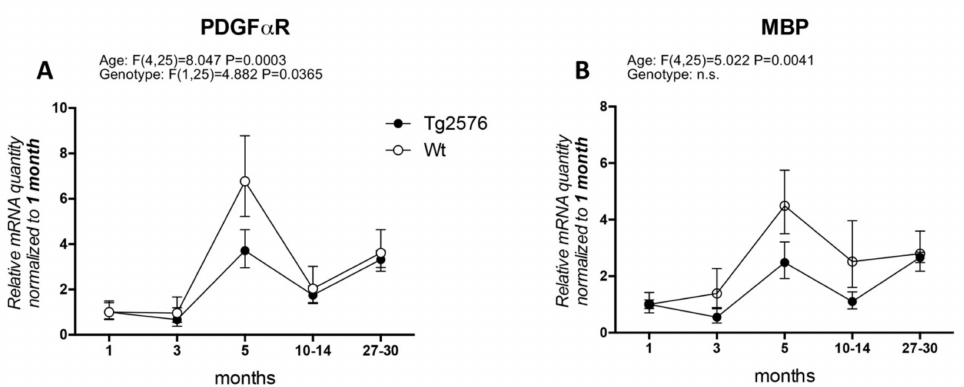
Figure 1. Age-related variation of oligodendrocyte lineage markers. ( A ) platelet-derived growth factor alpha receptor ( PDGF α R ) gene expression in Wt and Tg2576 at di ff erent age timepoints; ( B ) myelin basic protein ( MBP ) gene expression in Wt and Tg2576 at di ff erent age time points. Relative expression has been normalized to 1 month matched for each genotype. Statistical analysis has been performed through 2-way ANOVA, considering age (months) and genotype (Wt and Tg2576) as variables; n = 3–5. Results are significant when p < 0.05.